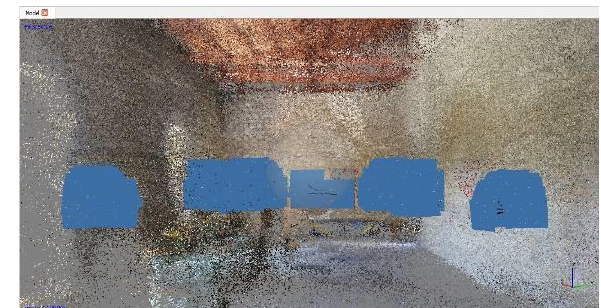
Figure 3. The sparse cloud reconstruction with the indication of the GCP